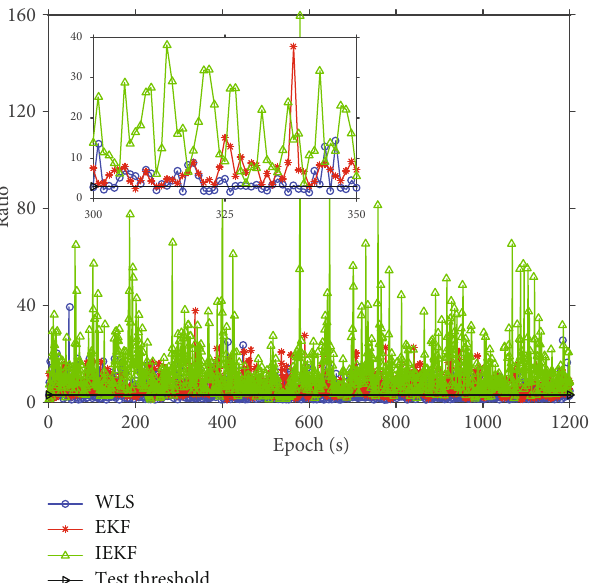
Figure 7: The ADOP values with pseudorange precision (Data 1).